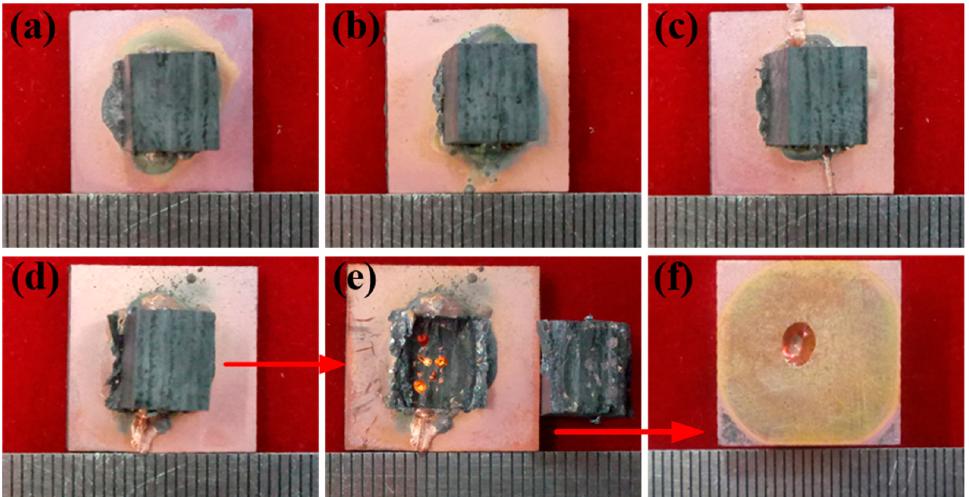
Figure 5. Schematic diagram of macroscopic joint forming of composite filler metal with different Ti contents at the optimal parameter. ( a ) 4.5 wt.%, ( b ) 6 wt.%, ( c ) 7.5 wt.%, and ( d ) 9 wt.% with fracture morphology ( e ) and back-welding shape ( f ).